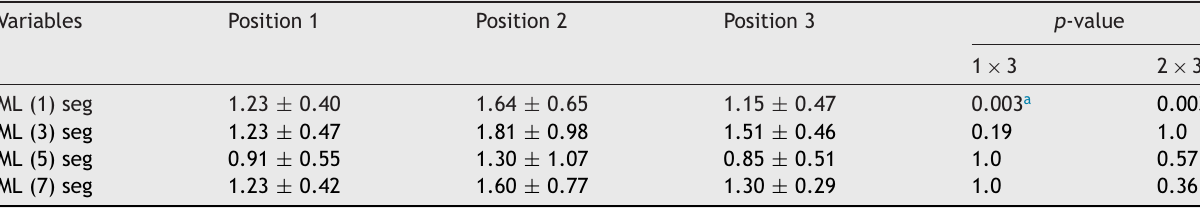
Table 2 Mean and standard deviation of the variable movement latency (ML) of the stability limit, in seconds. Variables